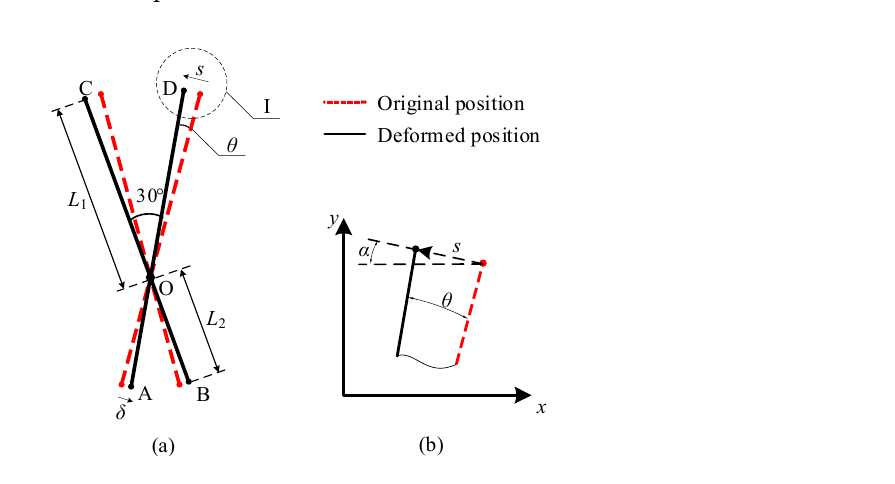
Figure 3. Motion principle of the actuator. Figure 3a–c illustrate the motion processes along the positive x -axis (forward motion), and Figure 3d–f illustrate the motion processes along the negative x -axis (reverse motion).